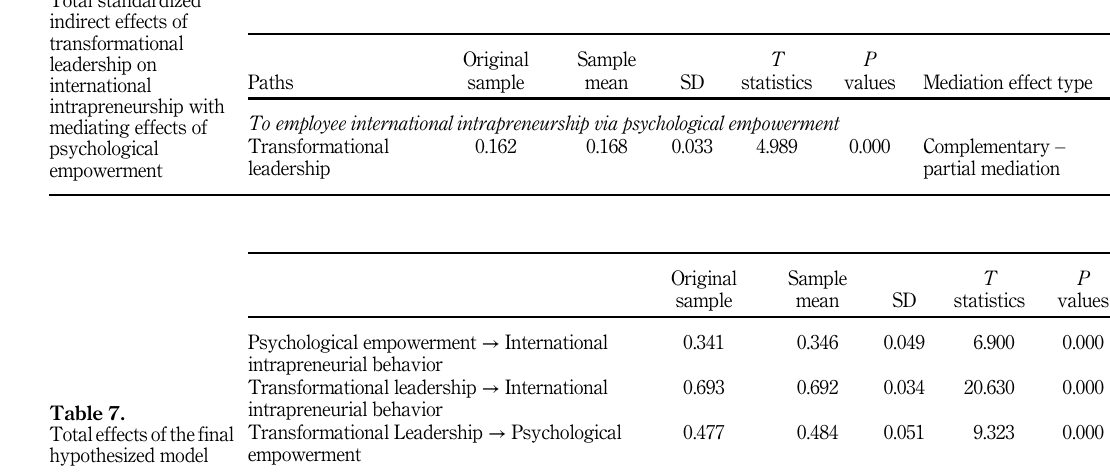
Table 7. Totaleffectsofthefinal hypothesized